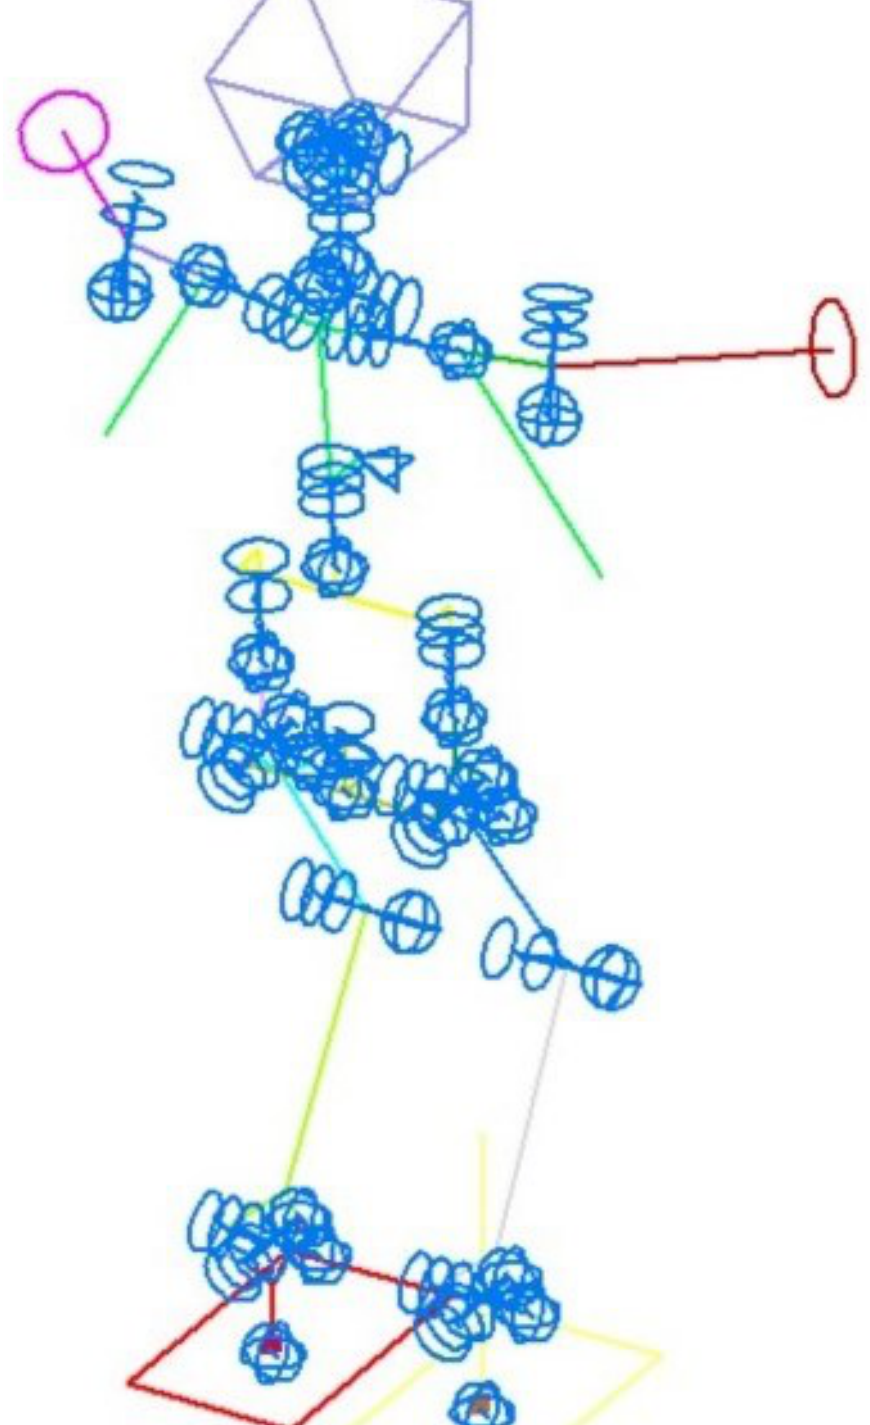
Figure 3. The calculation scheme of an android robot. Blue markers are the links; other colors mark the different bodies of the